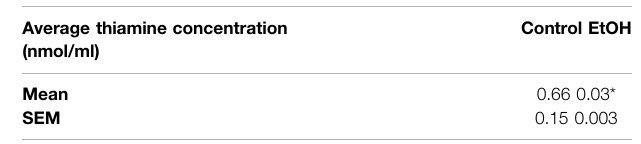
TABLE 1 | Thiamine concentrations in the whole